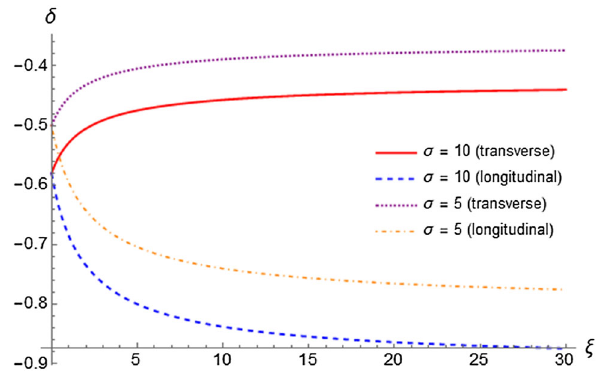
Fig. 1 Plot of the relative velocity differences δ ⊥ (ξ | σ) (38) for σ = 5 (dotted line) and σ = 10 (solid line) and δ (cid:5) (ξ | σ) (45) for σ = 5 (dash- dotted line) and σ = 10 (dashed line) as functions of the anisotropy parameter ξ . A decrease (increase) in δ ⊥ , (cid:5) (ξ | σ) indicates weakening (strengthening) of the shock wave